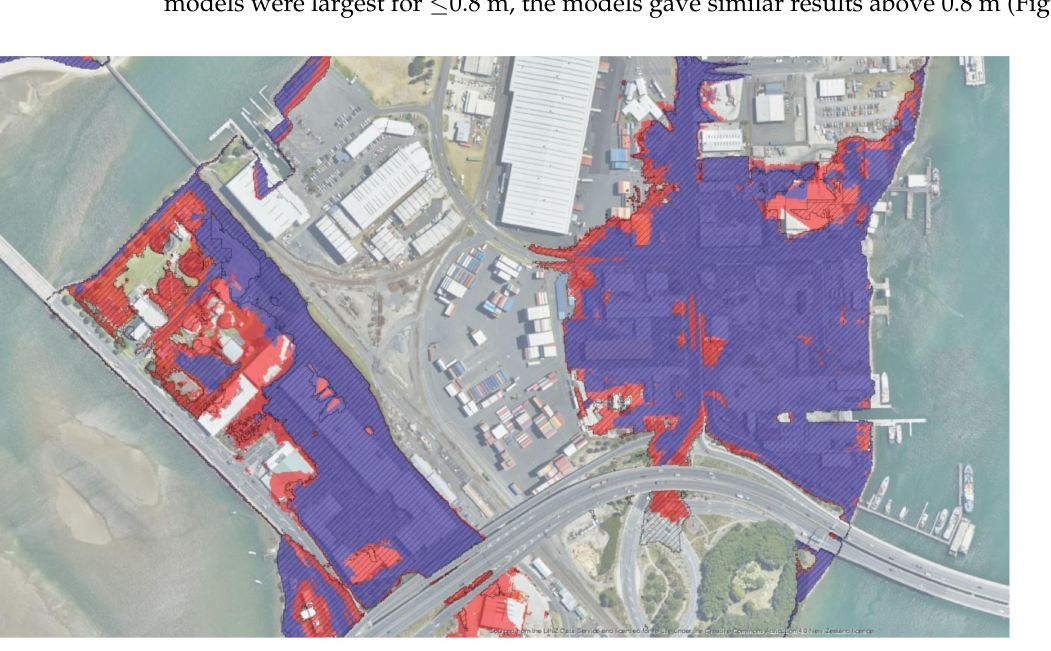
Figure 6. Comparison of model types for 1% AEP coastal flooding + 0.4 m RSLR, at a port storage facility in Tauranga Harbour. Red = dynamic, purple = static-planar, hashed =